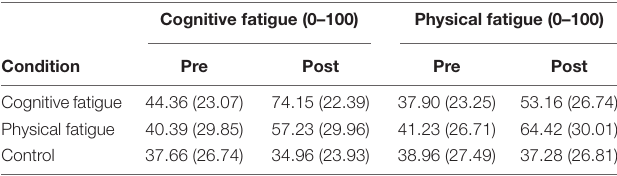
TABLE 1 | Means and standard deviations of self-reported fatigue per condition and per